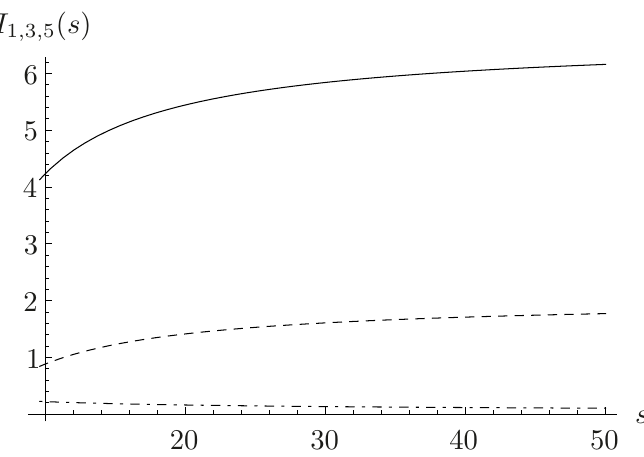
Figure 6 . Functions I 1 ( s ) (see eq. (B.29)) (solid line), I 3 ( s ) (dashed line), and the correction I 5 ( s ) l ((cid:3)) p (cid:14) ( s ) = ( m p (cid:12) (cid:3) ) (dash-dotted line). Open